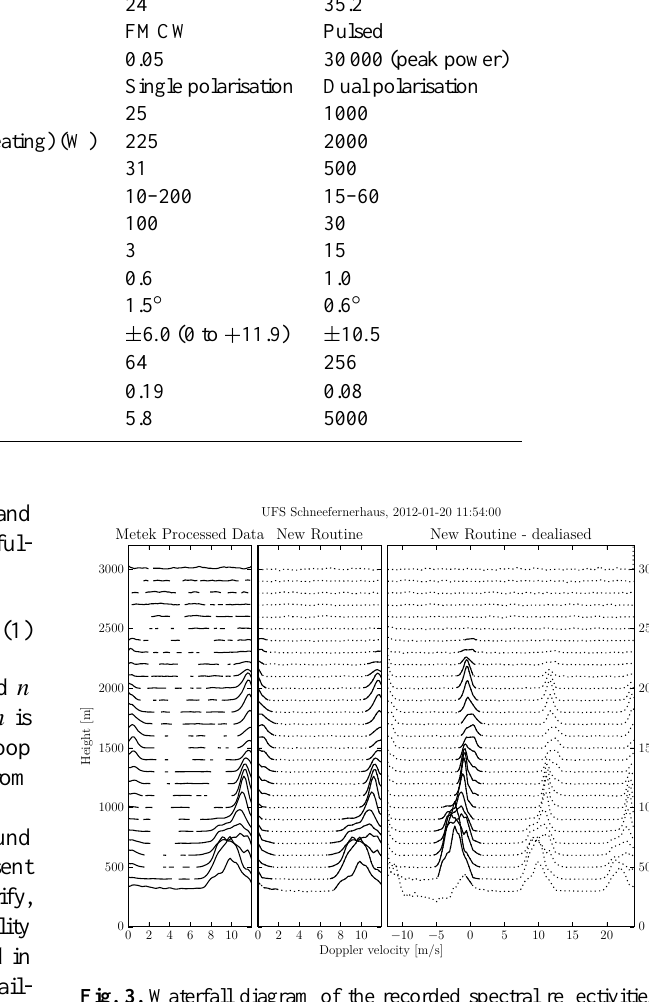
Fig. 3. Waterfall diagram of the recorded spectral reflectivities of the Doppler spectrum at 20 January 2012 11:54:00UTC from 300 to 3000m. Metek’s Averaged Data is presented left, the state of the spectra after noise removal by the proposed method is shown in the middle; the state after dealiasing is shown as well and can be seen at the right. The Averaged Data provides only spectral reflectivity densities exceeding zero (see text); the new algorithm distinguishes between noise (dotted) and peak